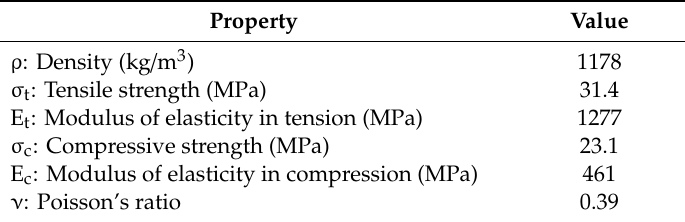
Table 1. Mechanical properties of the polymeric materials